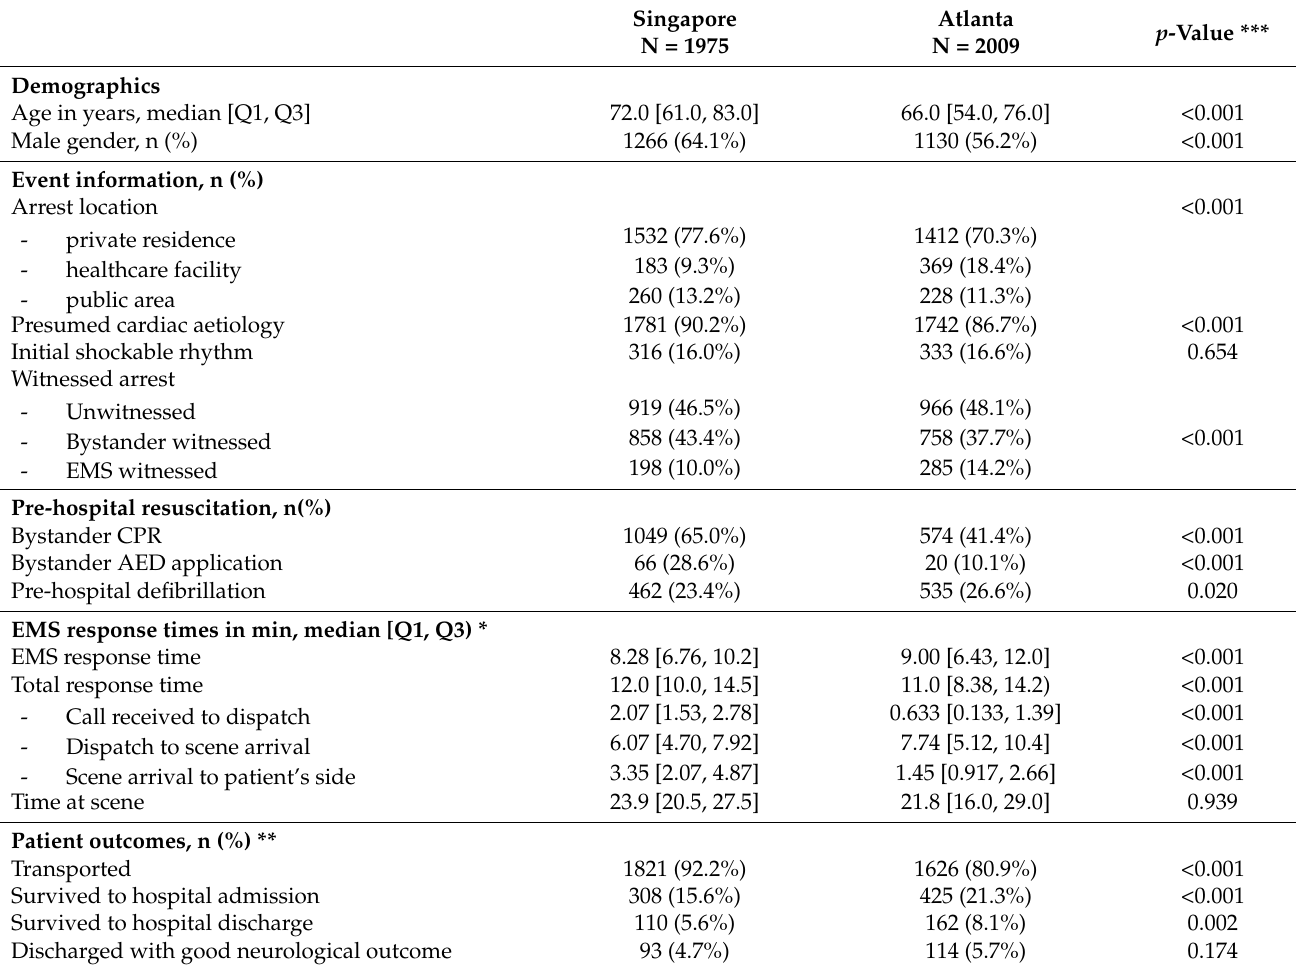
Table 2. Baseline characteristics of EMS-treated OHCA